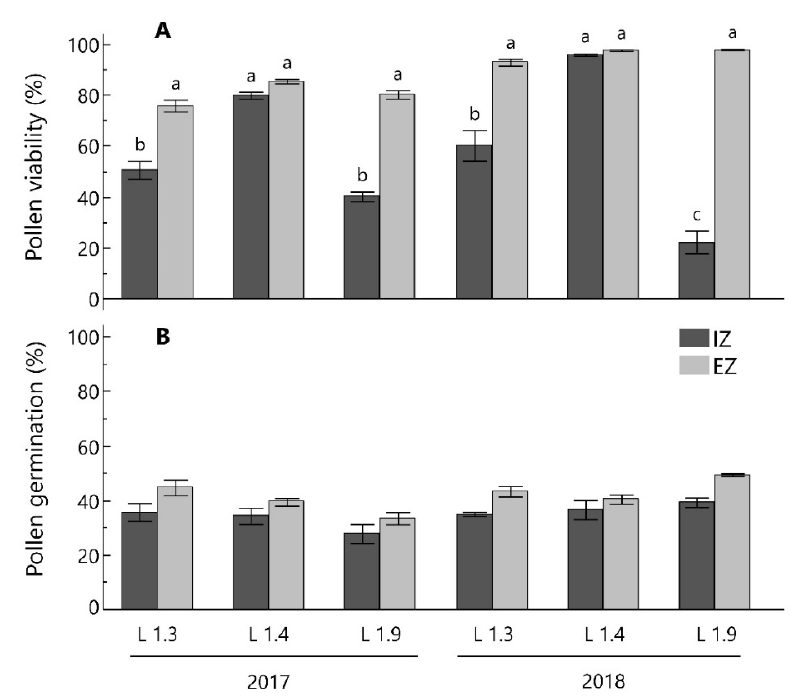
Figure 5. Percentage of viable pollen grains ( A ) and pollen germination ( B ) from internal (IZ) and external zone (EZ) of the canopy. Data refer to the 2017 and 2018 spring seasons for three Leccino olive clones (L 1.3, L 1.4, L 1.9). Histograms are means ± standard error. Different letters indicate differences at p ≤ 0.05 (Tukey’s test) among the Clone-Canopy Position combinations within each year. Letters are only presented when ANOVA indicate significant effect.